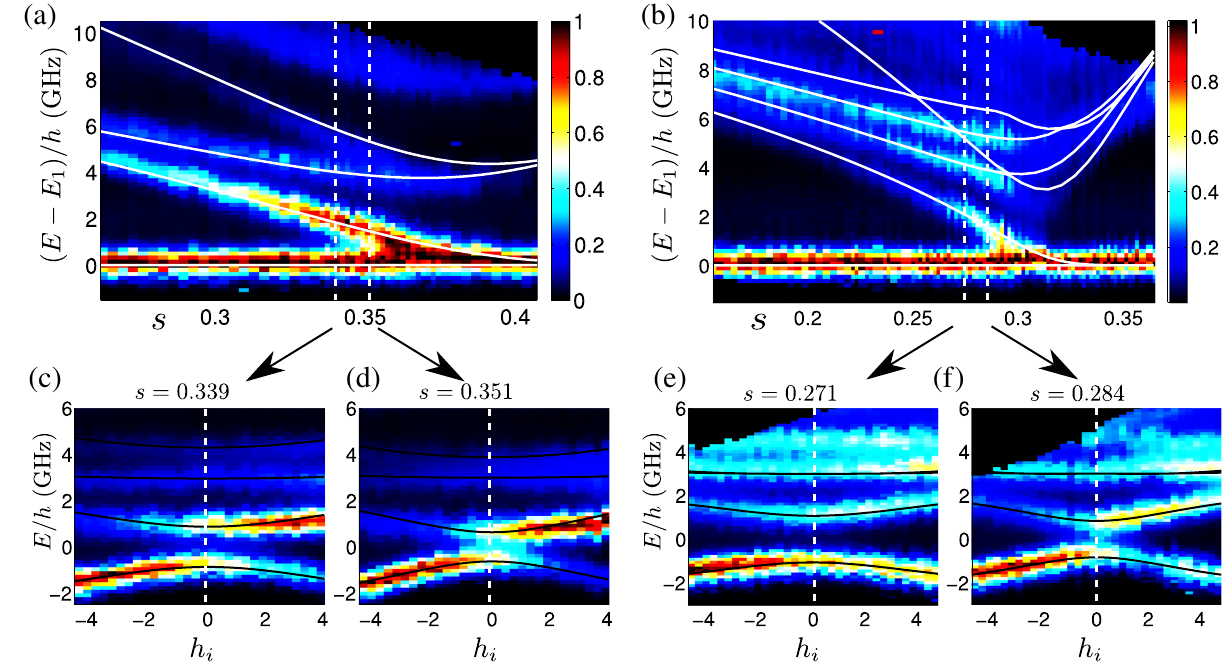
FIG. 3. Spectroscopic data for two- and eight-qubit systems plotted in false color (color indicates normalized qubit tunnel spectroscopy rates). A nonzero measurement (false color) indicates the presence of an eigenstate of the probed system at a given energy (ordinate) and s (abscissa). Panel (a) shows the measured eigenspectrum for the two-qubit system as a function of s . Panel (b) shows a similar set of measurements for the eight-qubit system. The ground-state energy E 1 has been subtracted from the data to aid in visualization. The solid curves indicate the theoretical expectations for the energy eigenvalues using independently calibrated qubit parameters and Hamiltonian (1). We emphasize that the solid curves are not a fit, but rather a prediction based on Hamiltonian (1) and measurements of Δ and E . The slight differences between the high-energy spectrum prediction and measurements are due to the additional states in the rf SQUID flux qubits. A full rf SQUID model that is in agreement with the measured high-energy spectrum is explored in the Supplemental Material [34]. Panels (c) and (d) show measured eigenspectra of the two-qubit system versus h 1 ¼ h 2 ≡ h for two values of annealing parameter s , s ¼ 0 . 339 and s ¼ 0 . 351 from left to right, respectively. Note the avoided crossing at h Panels (e) and (f) show analogous measured eigenspectra for the eight-qubit system (with h 1 ¼ (cid:3) (cid:3) (cid:3) ¼ h 8 ≡ h gap closes earlier in QA for this system, we show measurements for smaller s , s ¼ 0 . 271 and s ¼ 0 . 284 from left to right,